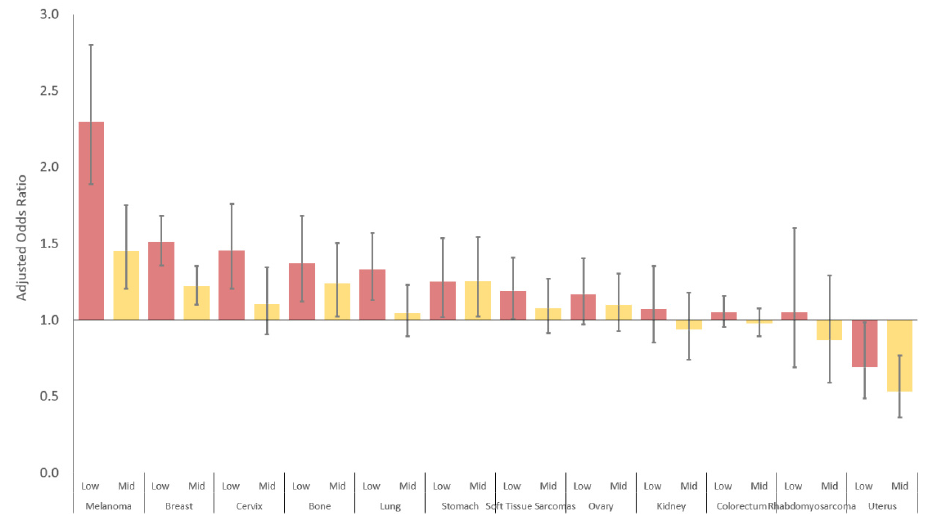
Figure 6 . Risk of metastatic disease for low SES AYAs by cancer site. Reference group: high SES.